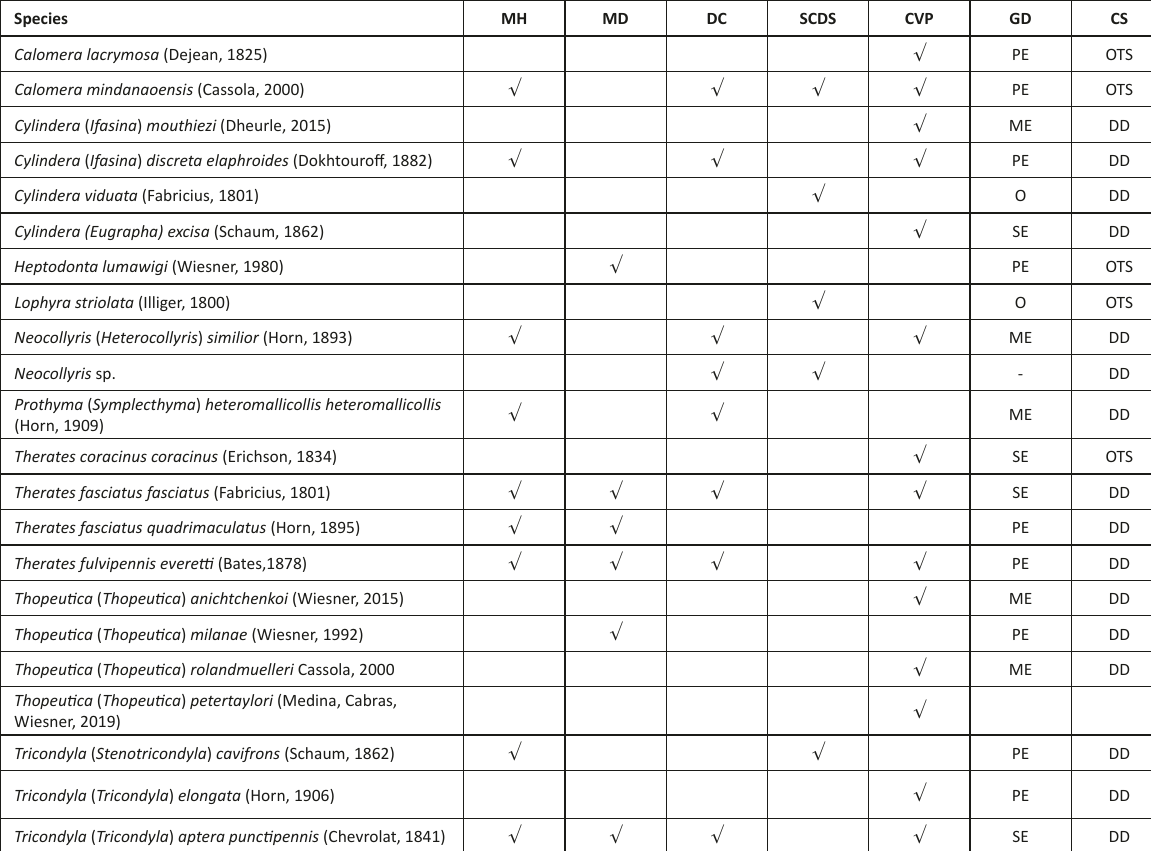
Table1. List of tiger beetles in Davao Region with their geographic distribution and conservation status. MH—Mt. Hamiguitan Range Wildlife Sanctuary | MD—Marilog District | DC—Davao City | SCDDS—Sta. Cruz, Davao del Sur | CVP—Compostela Valley Province | PE—Philippine Endemic | O—Oriental region | ME—Mindanao Endemic | SE—Southeast Asia | OTS—Other Threatened Species | DD—Data Deficient.